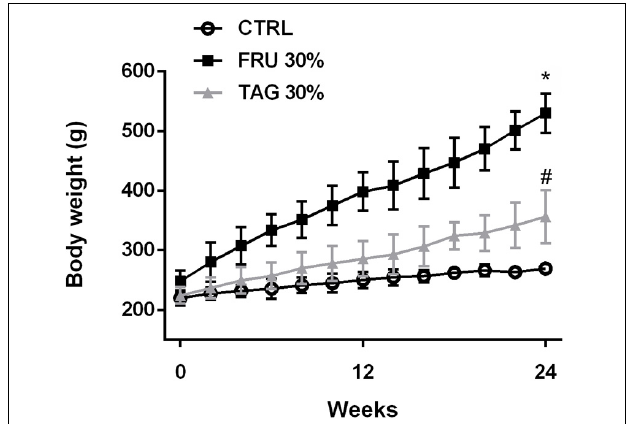
FIGURE 2 | Body weight gain in rats fed with controls (CTRL), D -tagatose (TAG 30%) and fructose (FRU 30%) groups for 24 weeks. Data are means ± SD for 14 animals per group. * p < 0.05 vs. CTRL, # p < 0.05 vs. FRU 30%.